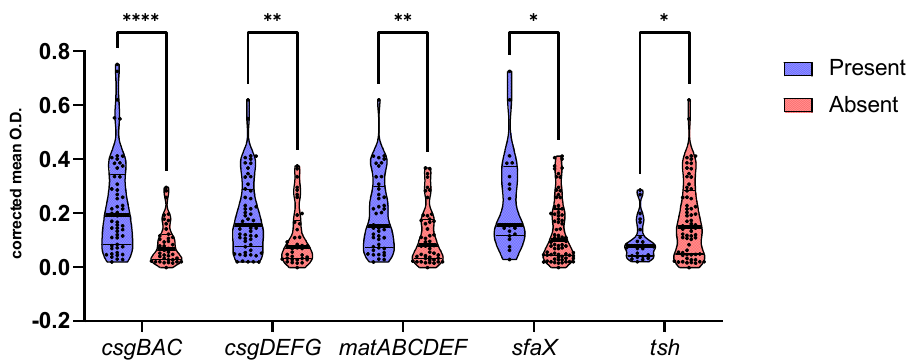
Figure 5. Corrected mean O.D. of strains harboring (blue) and lacking (red) operons csgBAC, csgDEFG, and matABCDEF and genes sfaX and tsh. Lines within violin plots represent median, 25th, and 75th percentile. p < 0.05 is shown as *, p < 0.01 as **, and p < 0.0001 as ****.